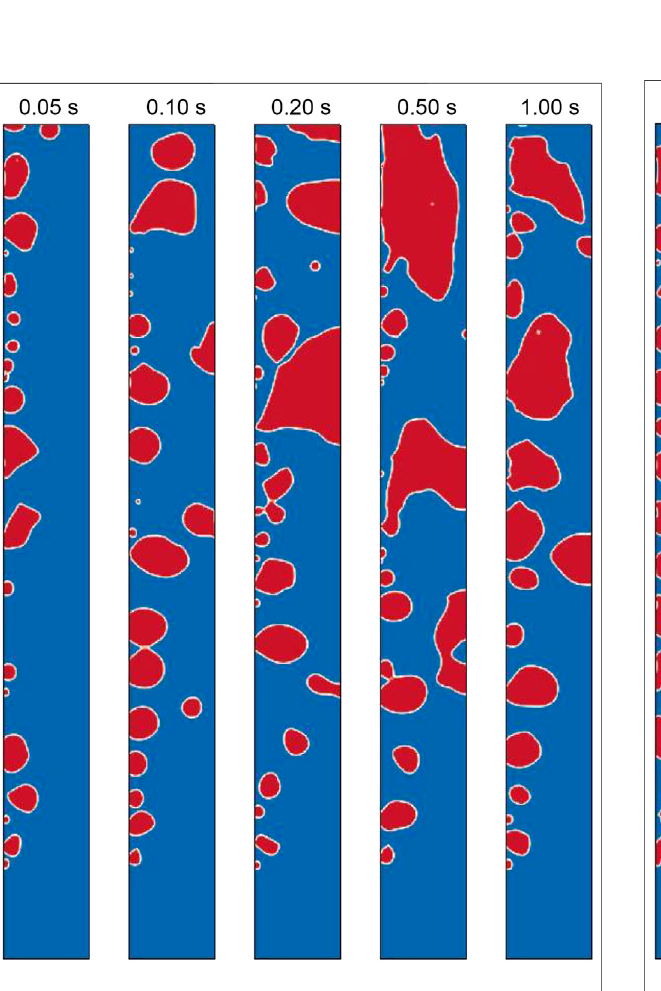
FIGURE 7 | Evolutionofphasedistributionatwallheat fl uxof300 kW/m 2 . FIGURE 8 | Evolutionofphasedistributionatwallheat fl uxof500 kW/m 2 .